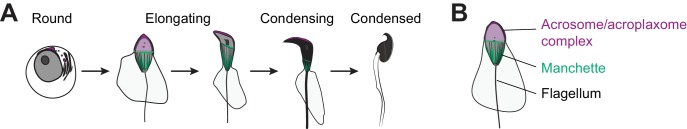
Key steps of spermiogenesis.(A) Schematic representation of murine male germ cells transitioning from round spermatids to elongated spermatozoa. These steps occur within the testis seminiferous epithelium and are conserved in all mammals. (B) Illustration of an elongating spermatid highlighting structural features that are established during spermiogenesis.